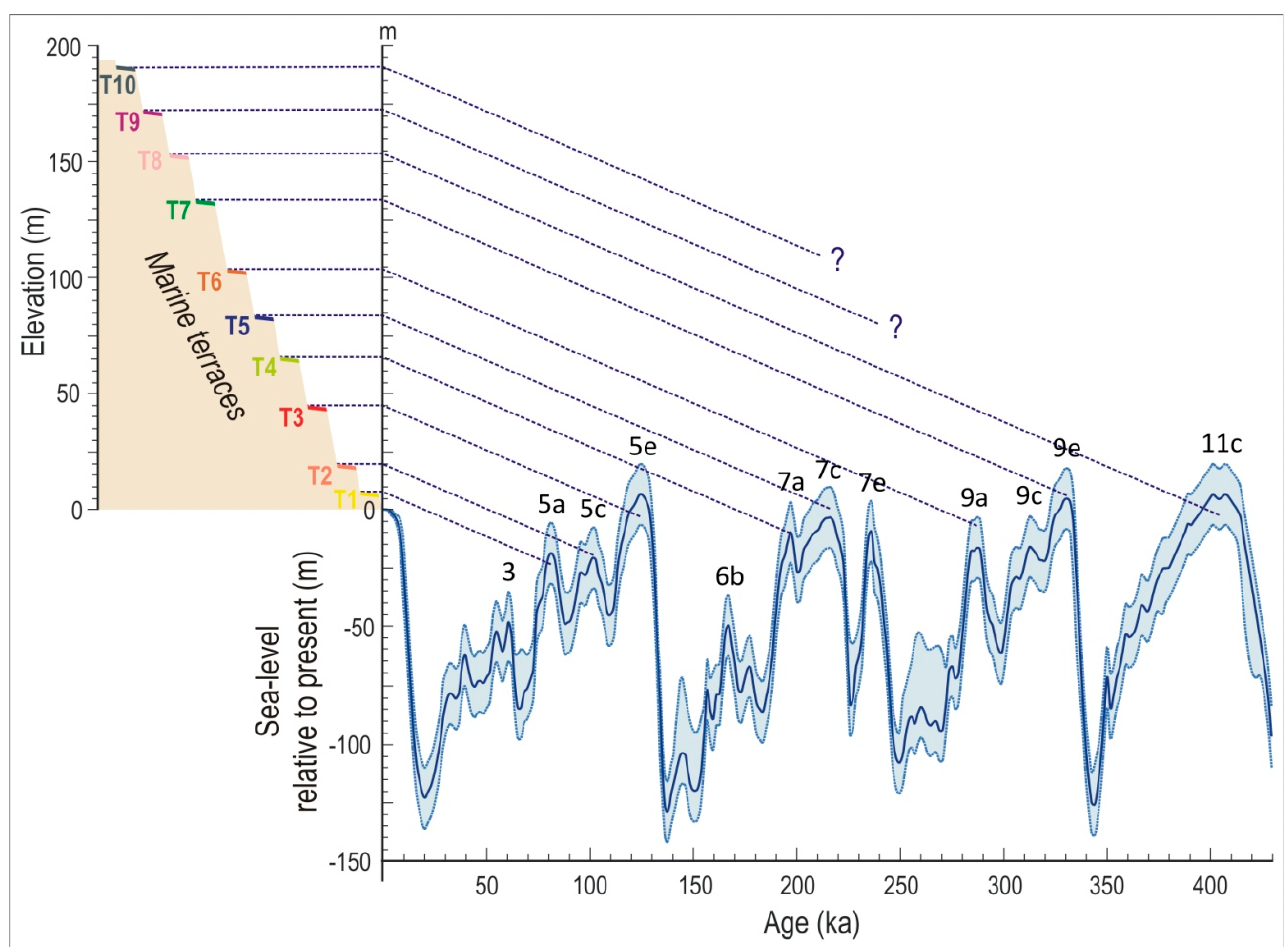
Figure 10. Correlation scheme for the marine terraces on southeastern Peloponnese with late Quaternary MIS sea-level highstands. The sea-level curve (with confidence interval) used is from Waelbroeck et al. [25].